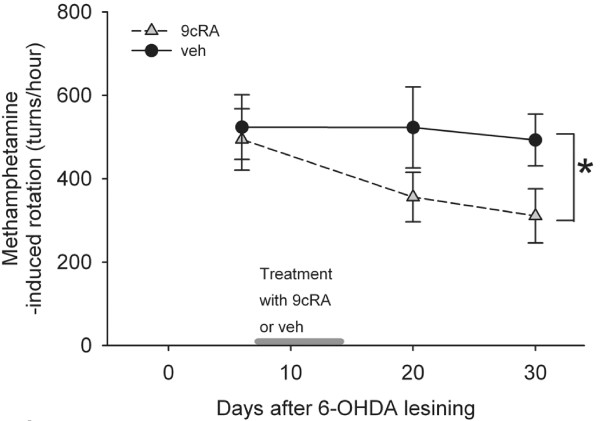
Post-treatment with 9cRA reduced methamphetamine –induced ipislateral rotation in hemiparkinsonian rats. Animals were lesioned by local administration of 6-OHDA at the left medial forebrain bundle on day 0. Rotation was induced by administration of 2.5 mg/kg methamphetamine at day 6 (prior treatment) and days 20 and 30 (after treatment). Treatment with 9cRA from day 7 to day 14 (i.c.v. and intranasal) significantly reduced rotation. Bar on X-axis represents the period animals received 9cRA or vehicle.